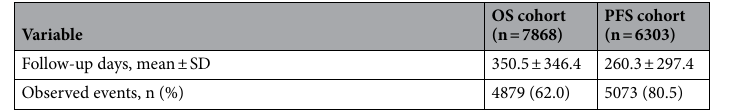
Table 1. Demographic and clinical characteristics of the OS and PFS cohorts. ECOG, Eastern Cooperative Oncology Group; ICI, immune checkpoint inhibitor; NOS, not otherwise specified; NSCLC, non-small cell lung cancer; OS, overall survival; PFS, progression-free survival; SD, standard deviation.